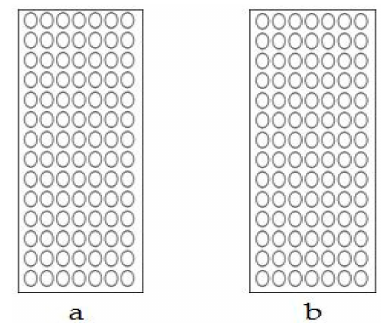
Figure 6. Scatter plot of Gmhsp17.6-L methylation after heat-shock treatment. ( a ) Non-deletion transgenic line 98-3-2. ( b ) Partial-deletion transgenic line 22-2-2.